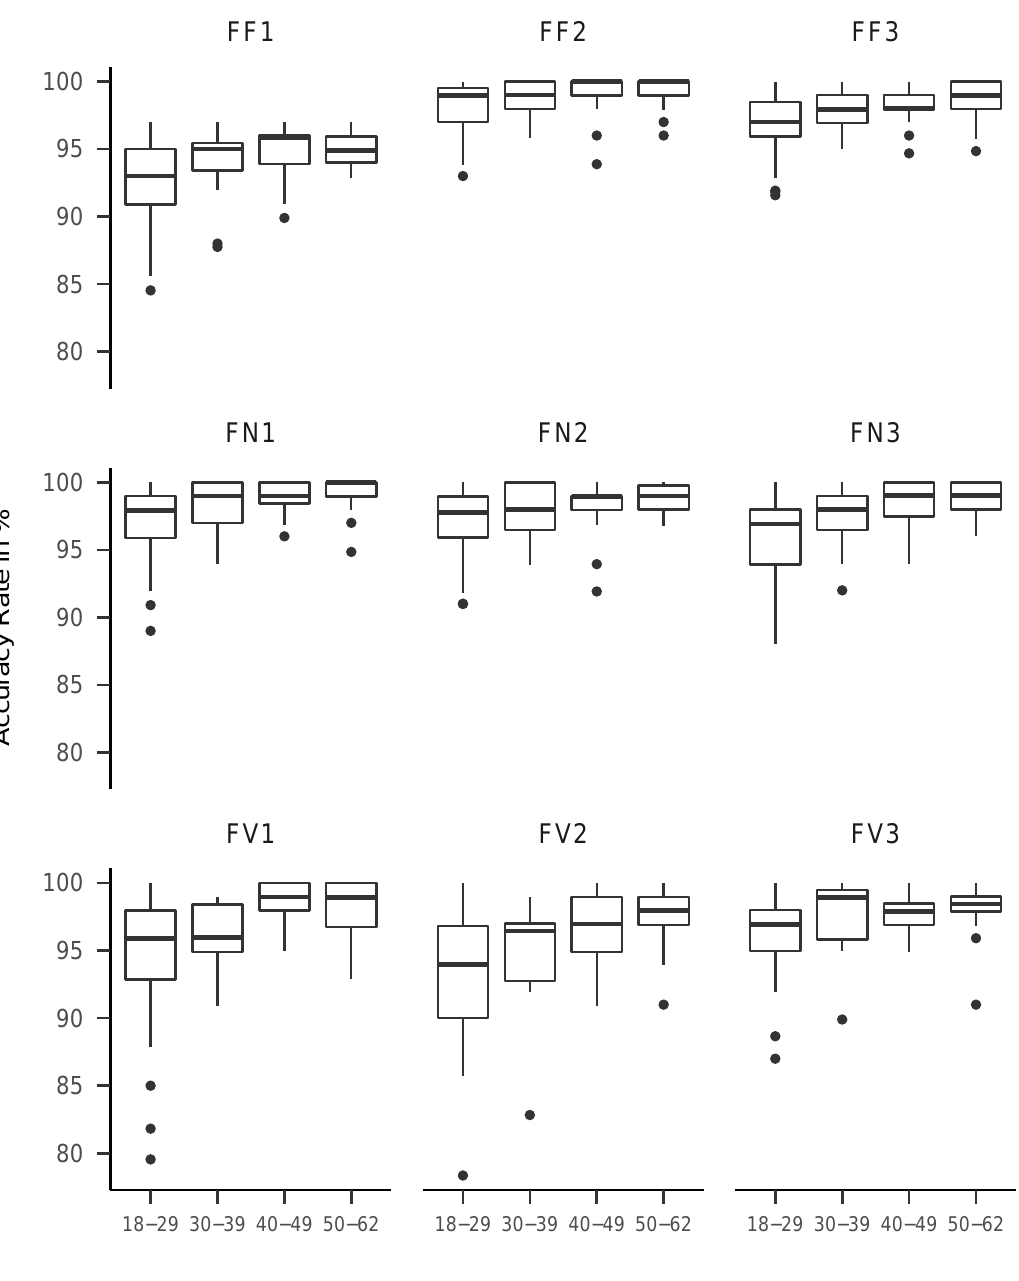
Figure A3. Boxplots of accuracy rates for all fast tasks, split by age groups. See Table 1 for an explanation of the task